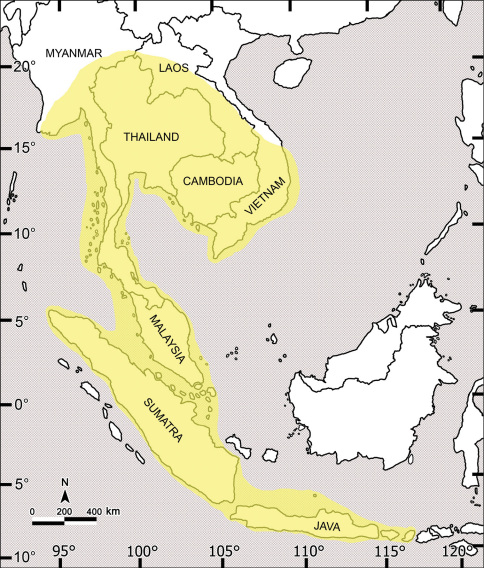
Distribution of the genus Orthomorpha.